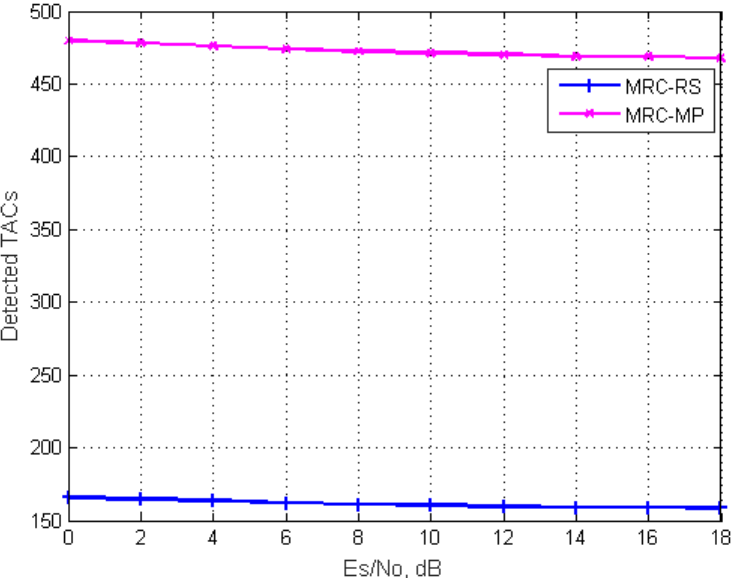
Figure 5. Average number of TACs detected by MRC-RS and MRC-MP algorithms for a GSM system with N t = 16, N r = 8, M = 16 and N p =